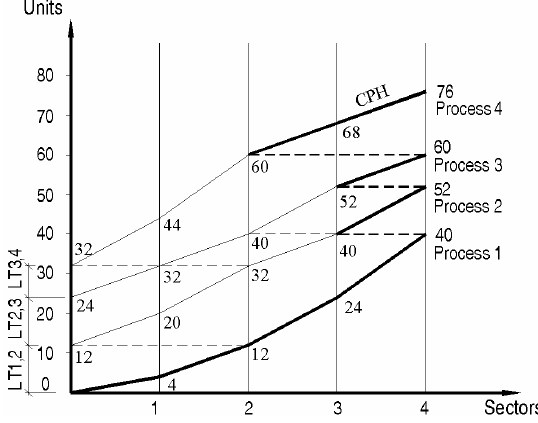
Fig 6. Network of dependences for input data given in Tab- le 1, CPH as bold